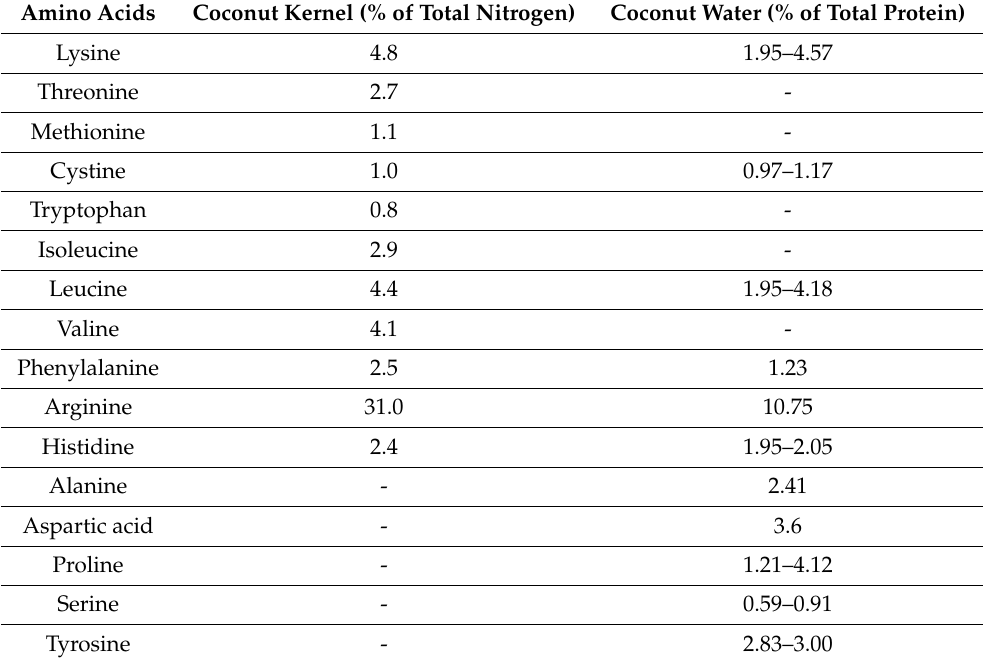
Table 2. Amino acid composition of coconut kernel [56] and coconut water